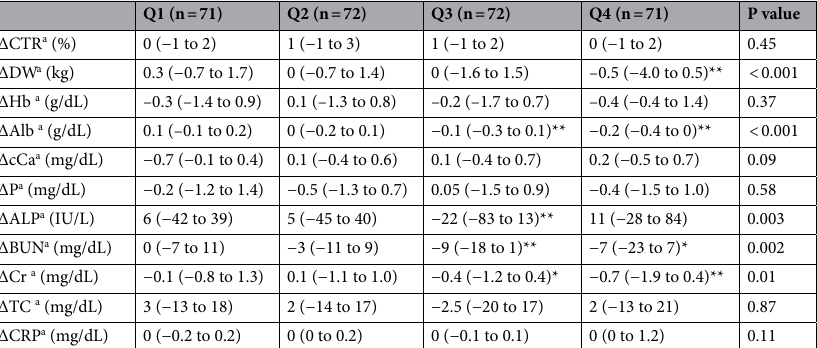
Table 3. Association between the quartile of psoas mass index and parameter change in one year. Kruskal– Wallis test was used. CTR cardiothoracic ratio, DW dry weight, Hb hemoglobin, Alb albumin, cCa corrected calcium, P phosphate, ALP alkaline phosphatase, BUN blood urea nitrogen, Cr creatinine, TC total cholesterol, CRP C-reactive protein. * vs Q1 p < 0.05. ** vs Q1 p < 0.01. a Median (interquartile